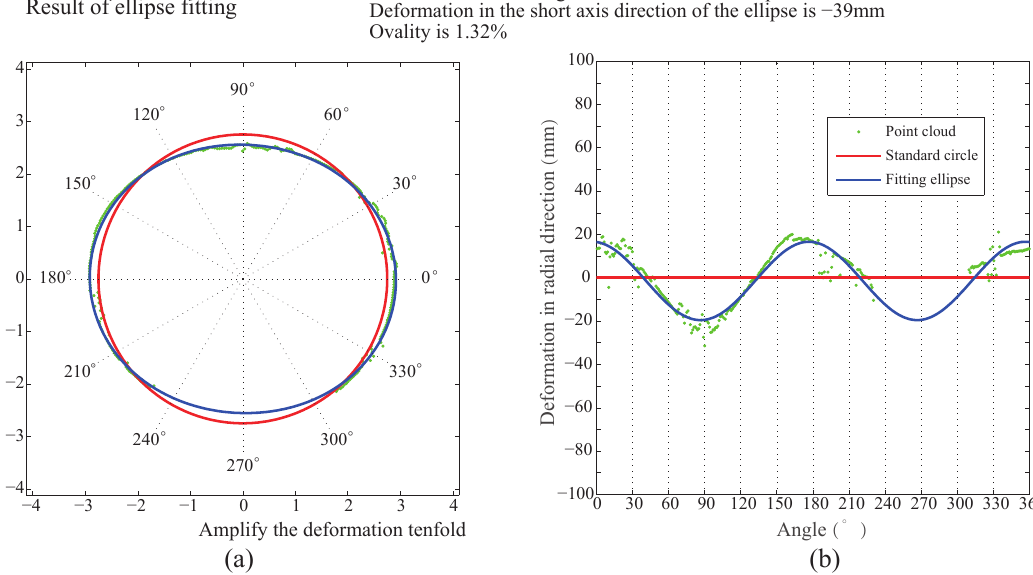
Figure 13. The ovality of a tunnel point cloud segment produced by the proposed monitoring system: ( a ) is the comparison between the ellipse fitted by the point cloud and the standard circle which represents the designed schema; ( b ) is the unfolding drawing of ( a ) and illustrates a more intuitive comparison of the deformation from different central